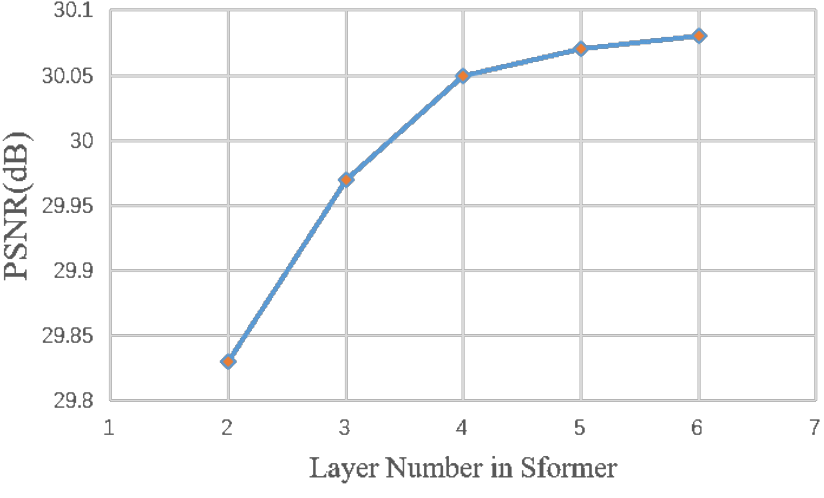
Figure 8. Impact of ETransformer layers in Sformer. Results are tested on Kodak with σ =